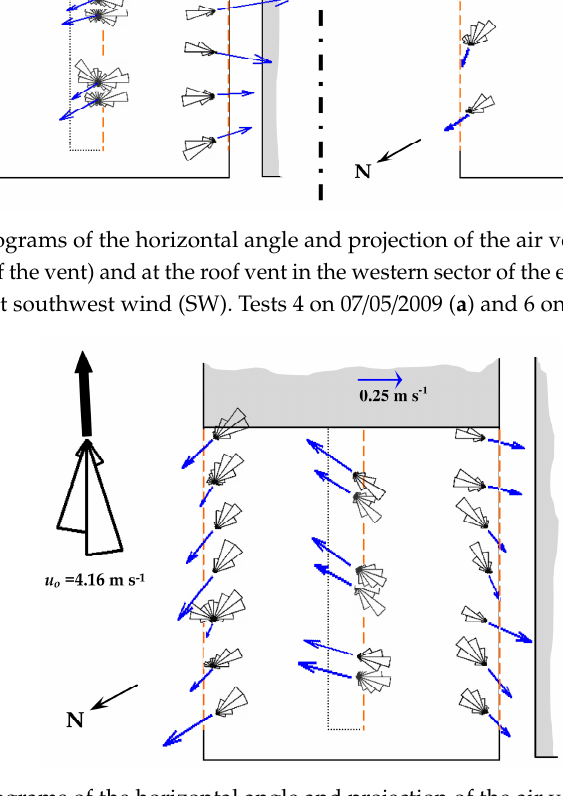
Figure 3. Polar histograms of the horizontal angle and projection of the air velocity (plane XY) at the side vents (middle of the vent) and at the roof vent in the western sector of the experimental greenhouse in conditions of light southwest wind (SW). Tests 4 on 07/05/2009 ( a ) and 6 on 23/04/2009 ( b ).